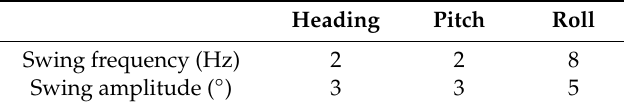
Table 5. The swing condition of turntable.